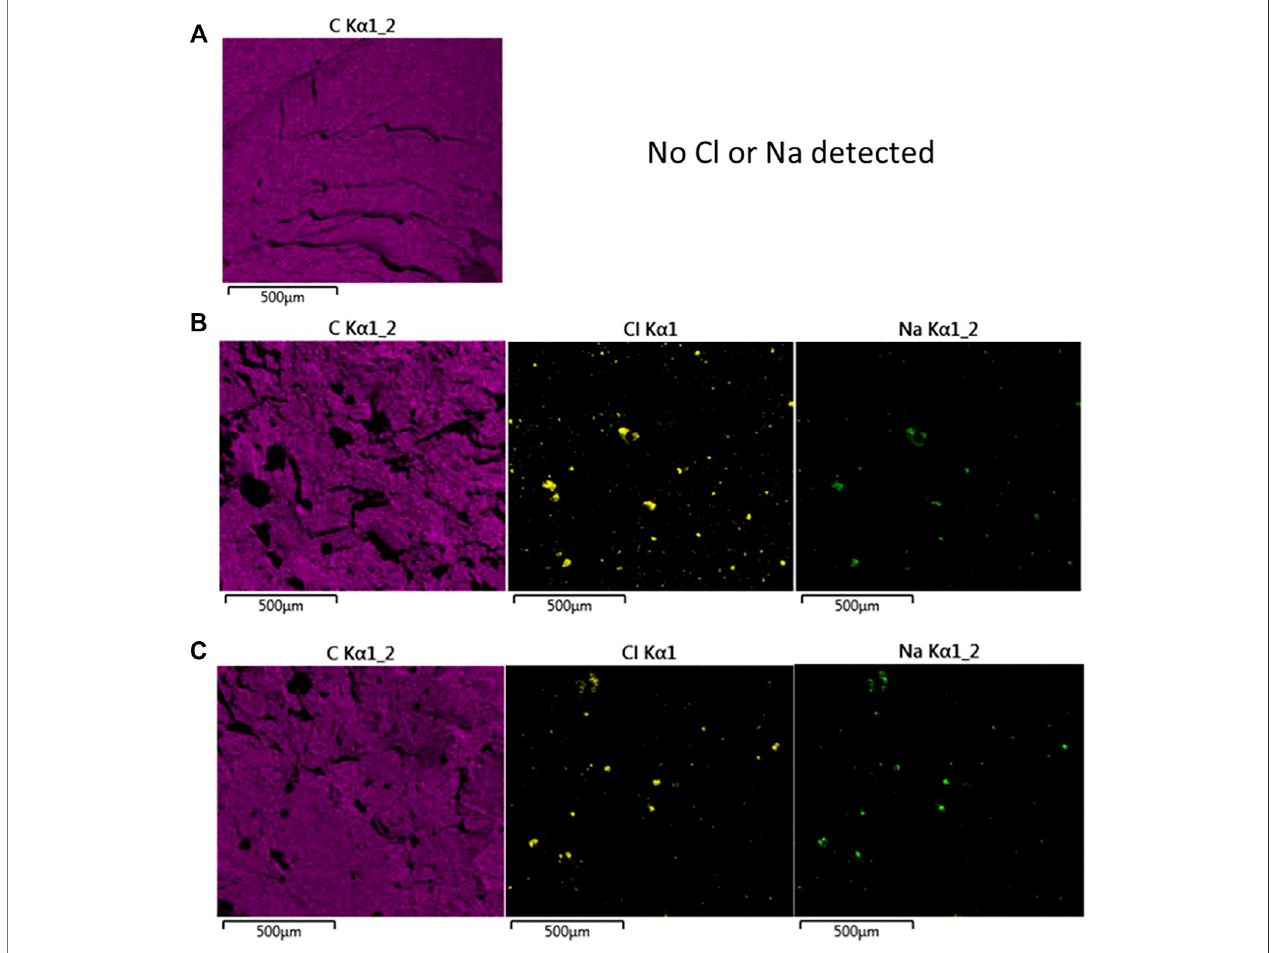
FIGURE 8 | EDS maps of cryofractured cross-sections (A) PCR LLDPE, (B) 10 wt. % Fly ash 1.5 wt. % C22 (C) 10 wt. % Fly ash no compatibilizer. Carbon (left), chlorine (middle), and sodium (right).